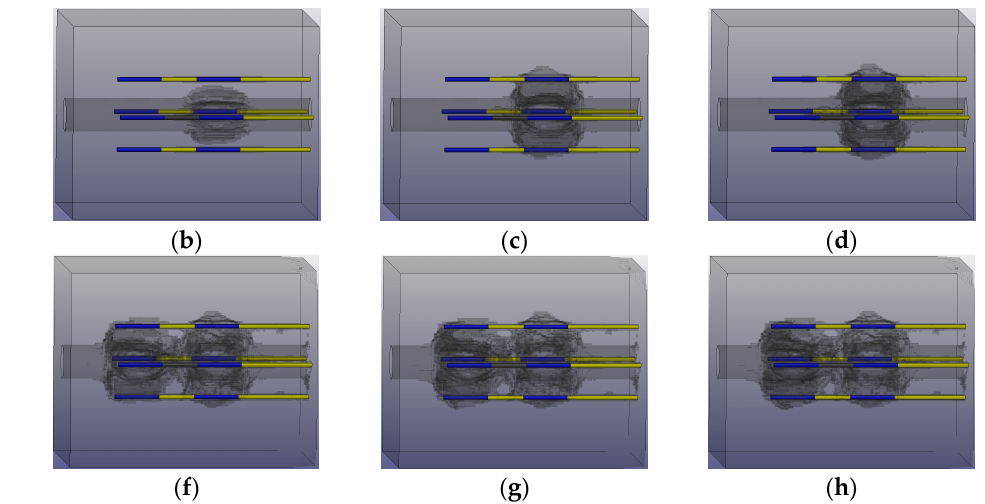
Figure 11. Numerical analysis results of the modified LLB method with deck charge technique: ( a ) 0 ms, ( b ) 0.5 ms, ( c ) 1.0 ms, ( d ) 1.5 ms, ( e ) 20.0 ms, ( f ) 20.5 ms, ( g ) 21.0 ms, ( h ) 21.5 ms.